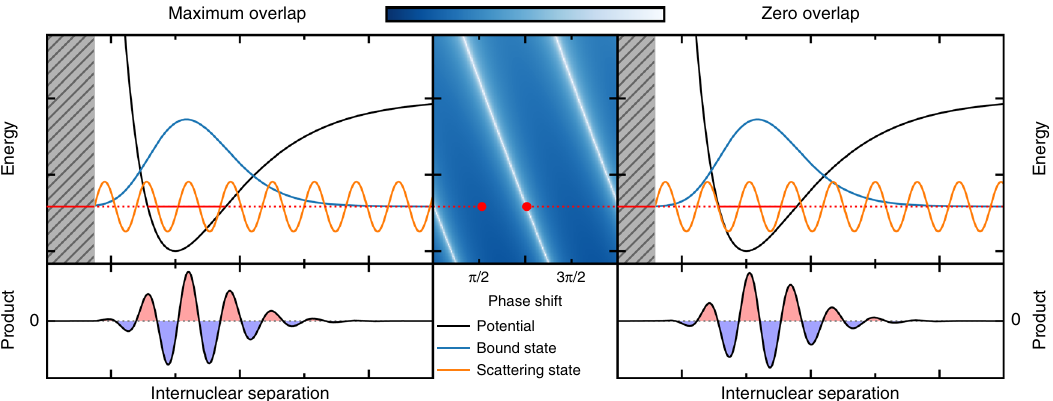
Fig. 1 Mechanism of phase protection of a FFR. The overlap of bound and continuum state determines, at least within the perturbative limit, the lifetime of an FFR: vanishing overlap results in in fi nite lifetime, indicated by white lines in the center panel. The scattering phase is determined by the position of the scattering channel's repulsive wall, here assumed to be a hard wall, as indicated by the gray shaded